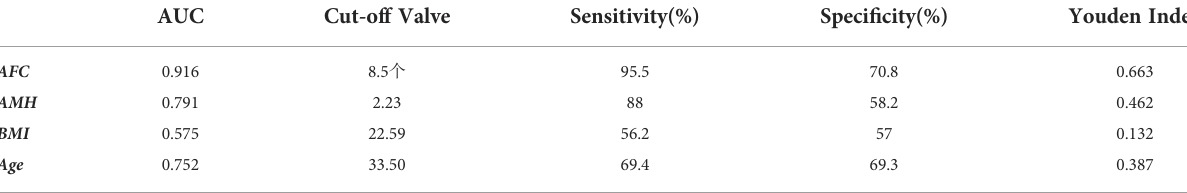
TABLE 4 Predictive comparison of different in fl uence factors and low ovarian response.